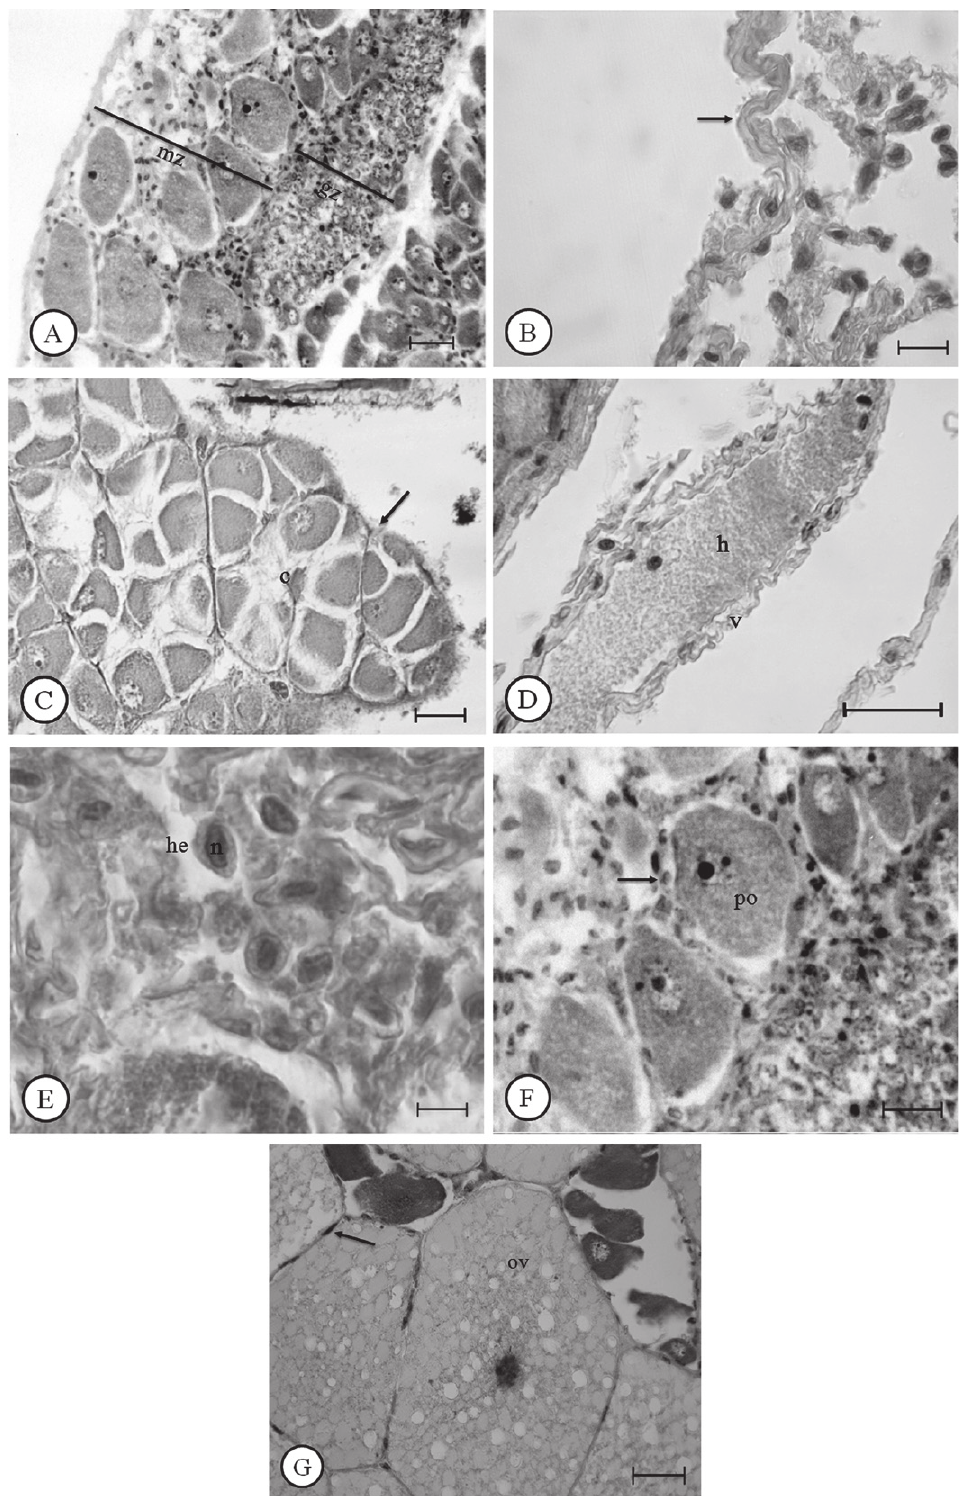
Fig . 2. – Photomicrograph of the somatic components of the ovary of Goniopsis cruentata stained with Gomori’s trichrome. a, longitudinal section of ovary - germinative zone (gz); maturation zone (mz). scale: 25 µm. b, external lining of ovary after spawning (arrow) with wavy ap- pearance characteristic of the stage. scale: 50 µm. C, previtellogenic ovary - periodic invaginations (arrow) in the lining in which cysts (c) are formed. scale: 50 µm. d, hemal vessel (v) in ovary after spawning. Hemolymph (h). scale: 30 µm. e, hemocytes (he). nucleus of hemocytes (n). scale: 4 µm. F, follicular cells (arrow) around previtellogenic oocytes (po). scale: 30 µm. G, follicular cells (arrow) in squamous form associated with late-stage oocytes (ov). scale: 50